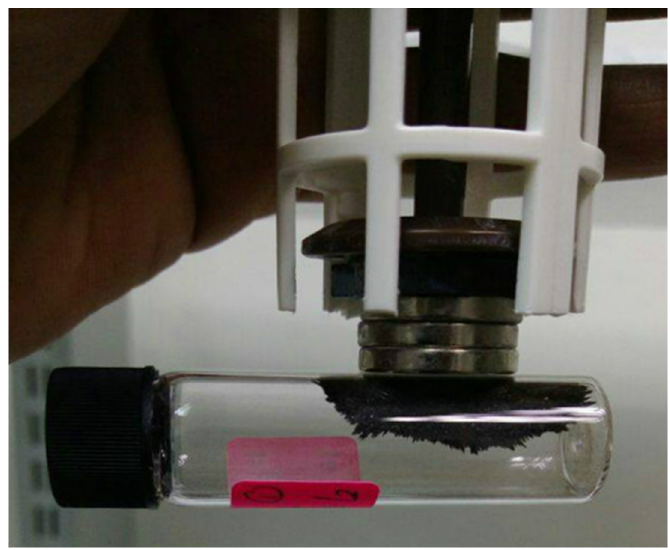
Figure 2. Response of synthesised MNPs under external magnetic field.